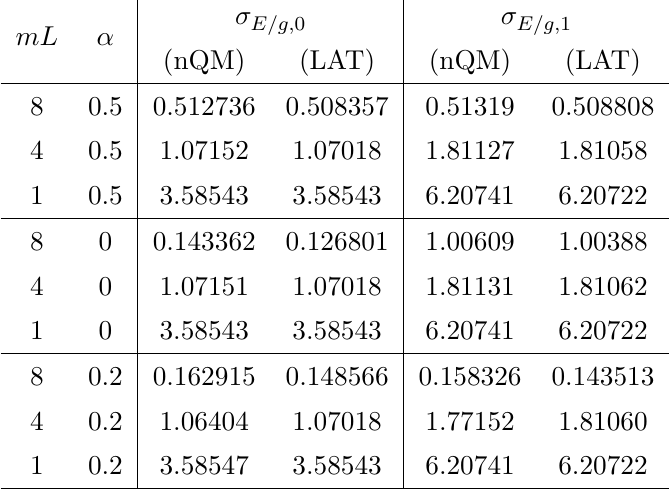
for m = 50 with various mL and diffrent background field Table 3. The standard deviations σ E/g g α on N = 10 lattice. The values in the ‘(nQM)’ columns are calculated using numerical bosonized quantum mechanics while those in the ‘(LAT)’ columns are obtained from lattice field